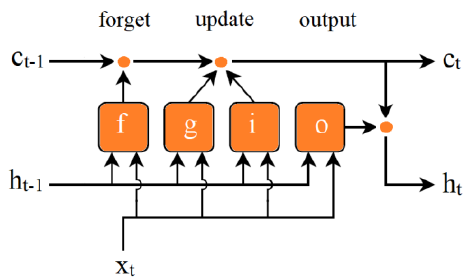
Figure 3. An LSTM cell with a new cell state c t , hidden states h t , input gate i, output gate o, cell candidate g, and forget gate f at time step t.